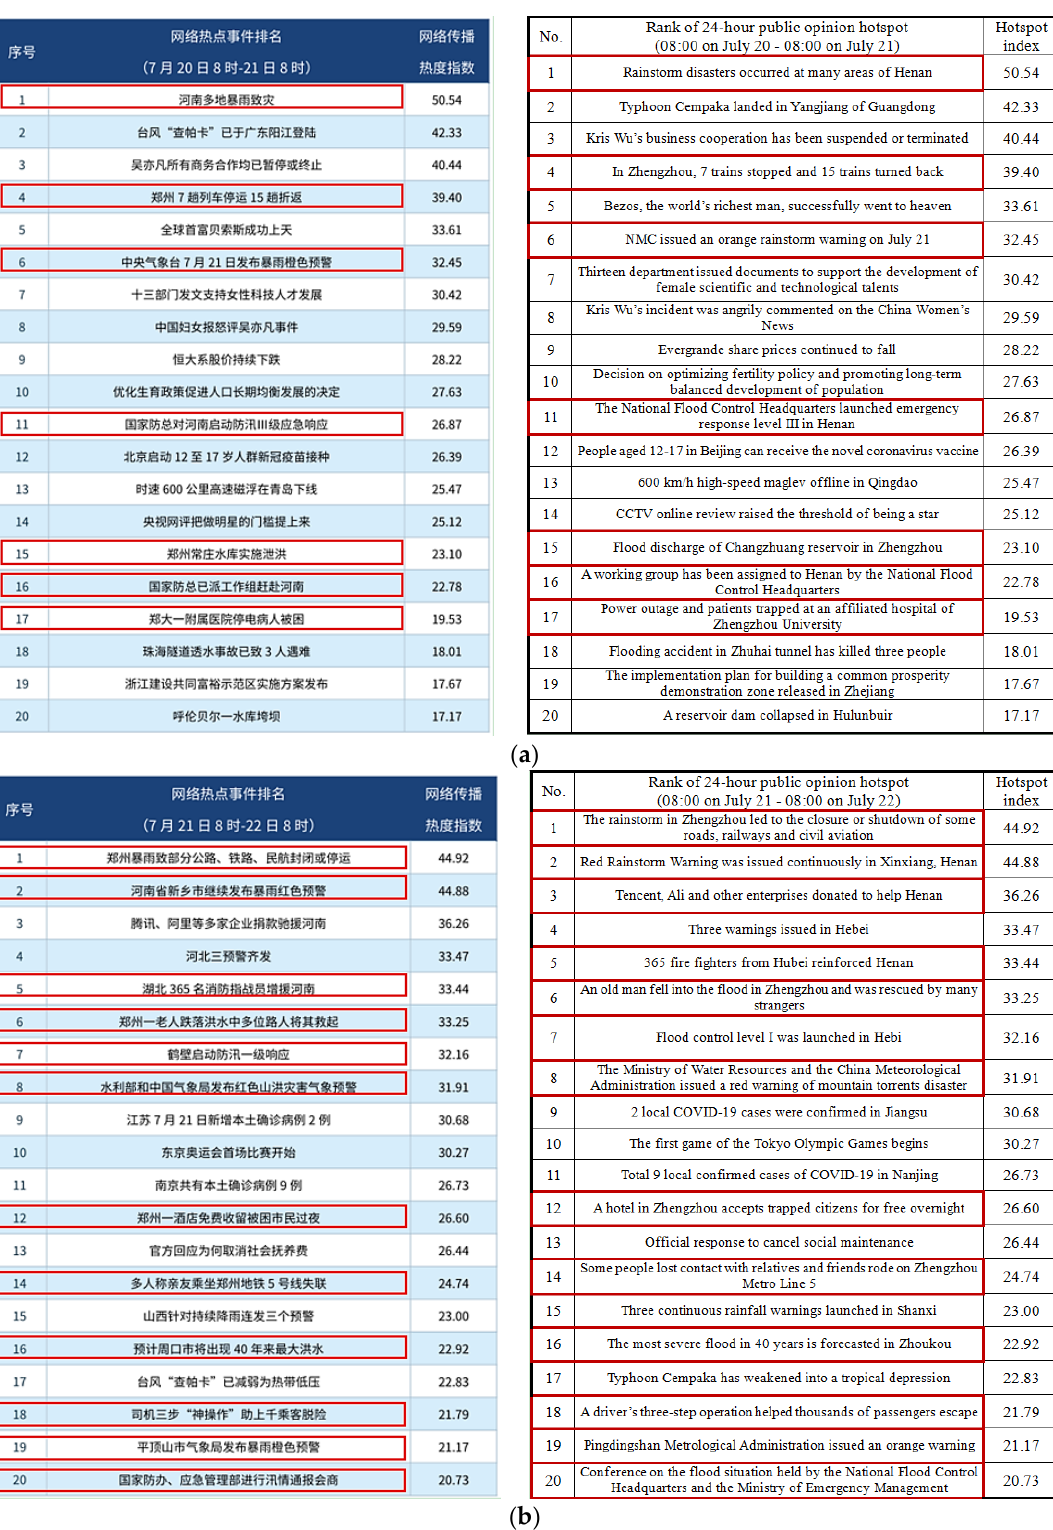
Figure 3. Public opinion hotspots from Sina Public Opinion: ( a ) hotspots on July 21; ( b ) hotspots on July 22 (redrawn from [11]).